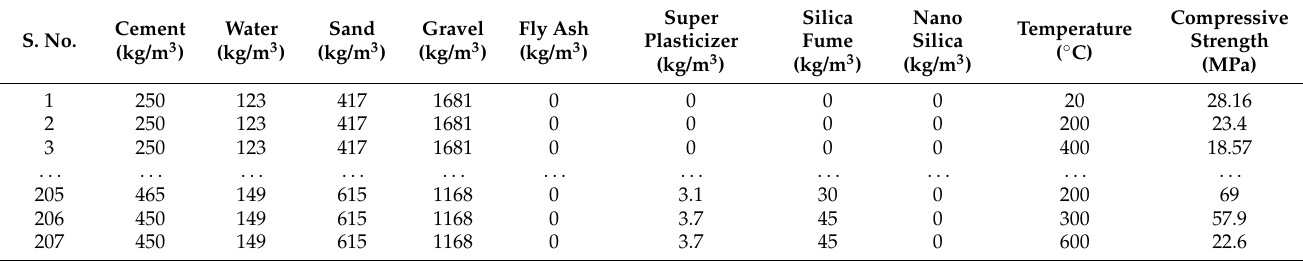
Table 1. Concrete compressive strength